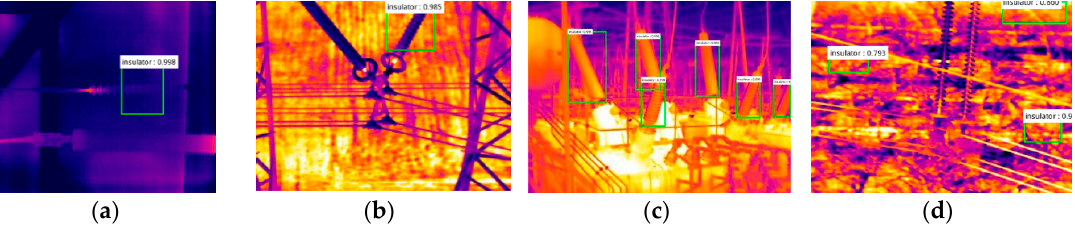
Figure 1. Insulator detection images obtained by fine-tuning the faster R-CNN: ( a ) Detection of insulators with color close to background; ( b ) detection of tilting insulators; ( c ) detection of insulators with different scales; ( d ) detection of insulators with occlusion problems.